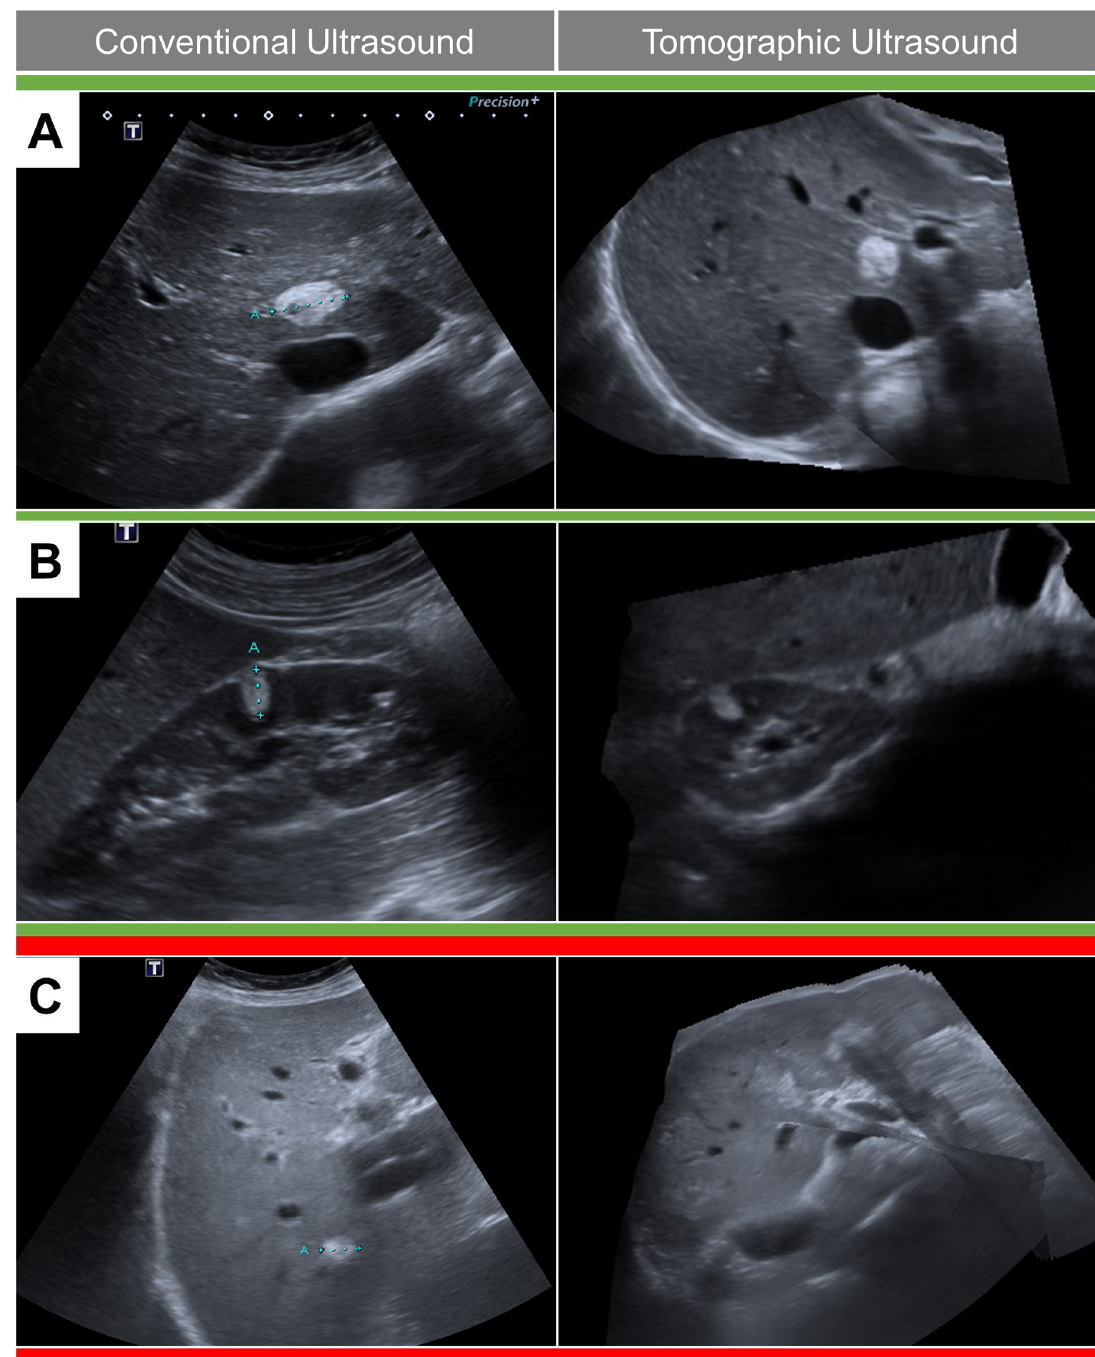
Fig 3. Impact of image quality and artifacts on tomographic ultrasound. Liver and kidney lesion are shown in conventional (left) and tomographic (right) ultrasound. Panels A and B represent examples with good image quality of the tomographic reconstruction. Panel C shows artifacts in the reconstructed image (right) which impairs the detection of the small hyperechoic lesion.